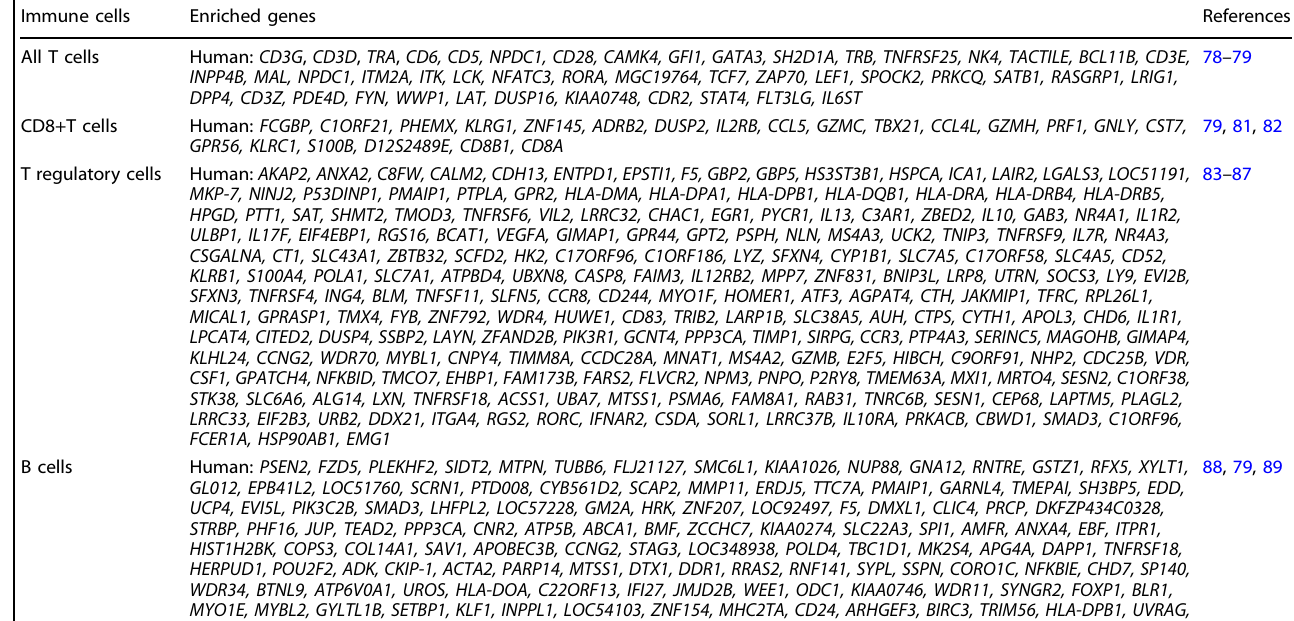
Table 1. Enriched genes in immune cells Immune cells Enriched